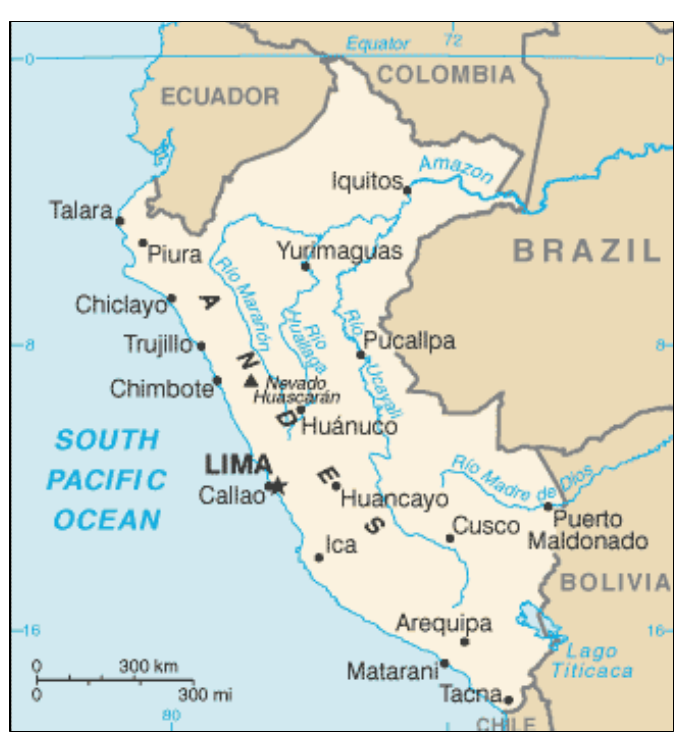
Figure 1. Map showing Peru and Lima Figure 2. Map showing the location of